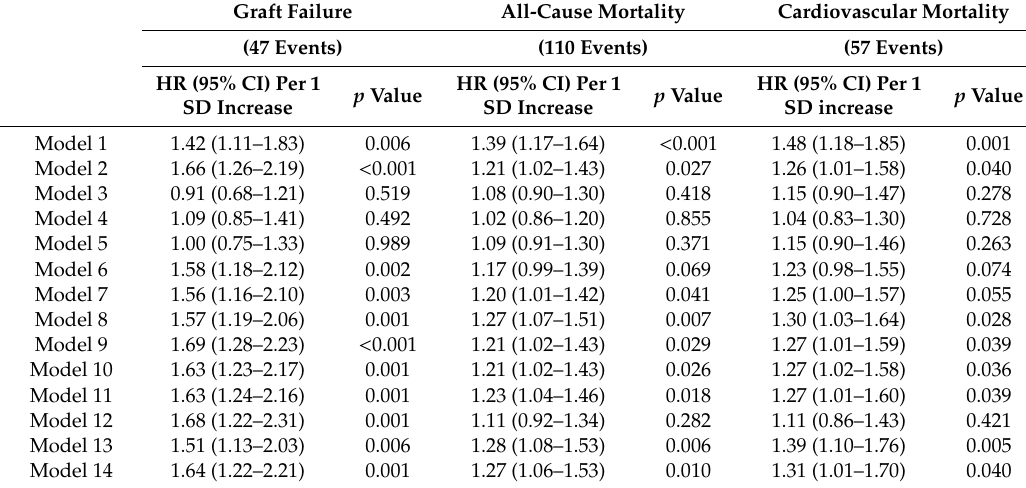
Table 2. Univariate and multivariate Cox regression analyses for graft failure, all-cause mortality, and cardiovascular mortality by plasma levels of group IIA secretory phospholipase A 2 (sPLA 2 -IIA).